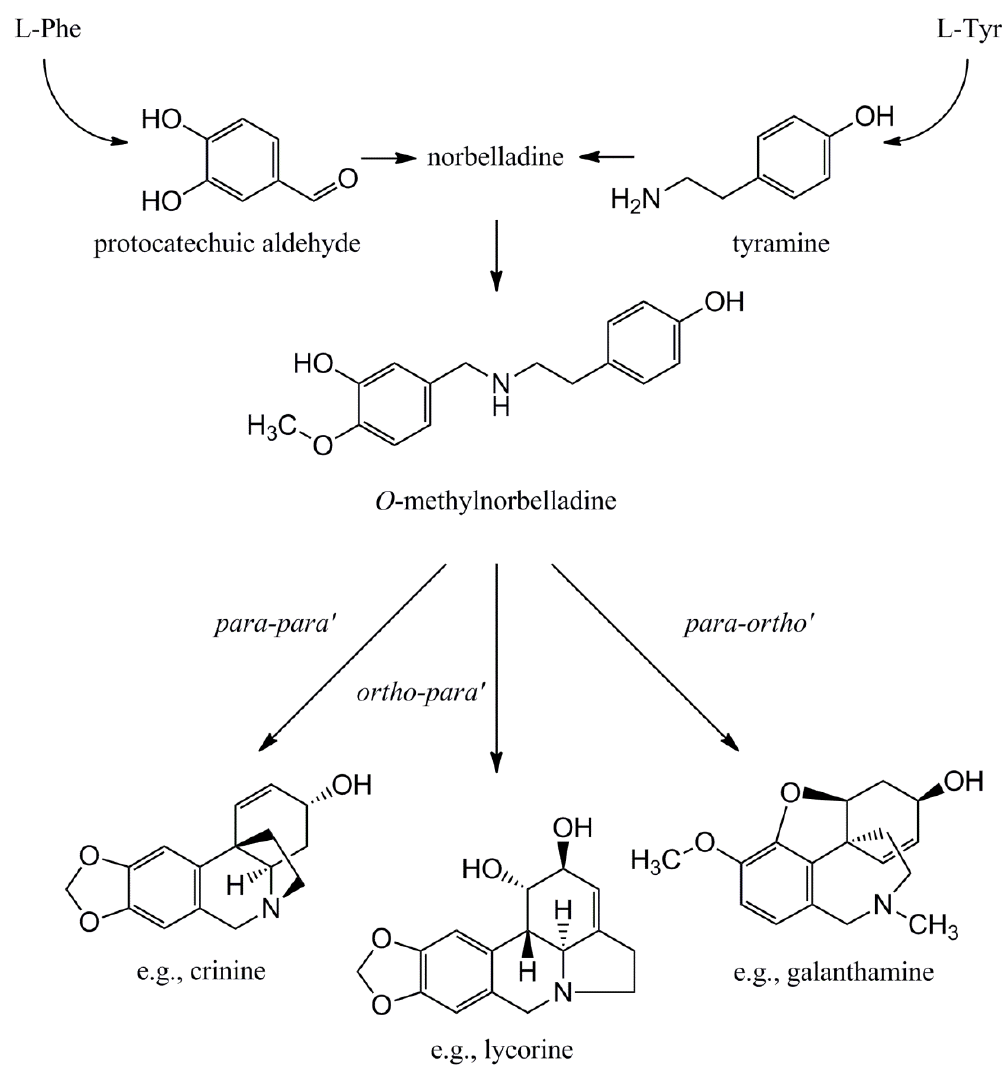
Figure 3. Schematic overview of Amaryllidaceae biosynthesis. Starting from the aromatic amino acids phenylalanine and tyrosine the common precursor O -methylnorbelladine is formed. Alternative ways of oxidative phenol coupling lead to the various Amaryllidaceae alkaloid skeleton